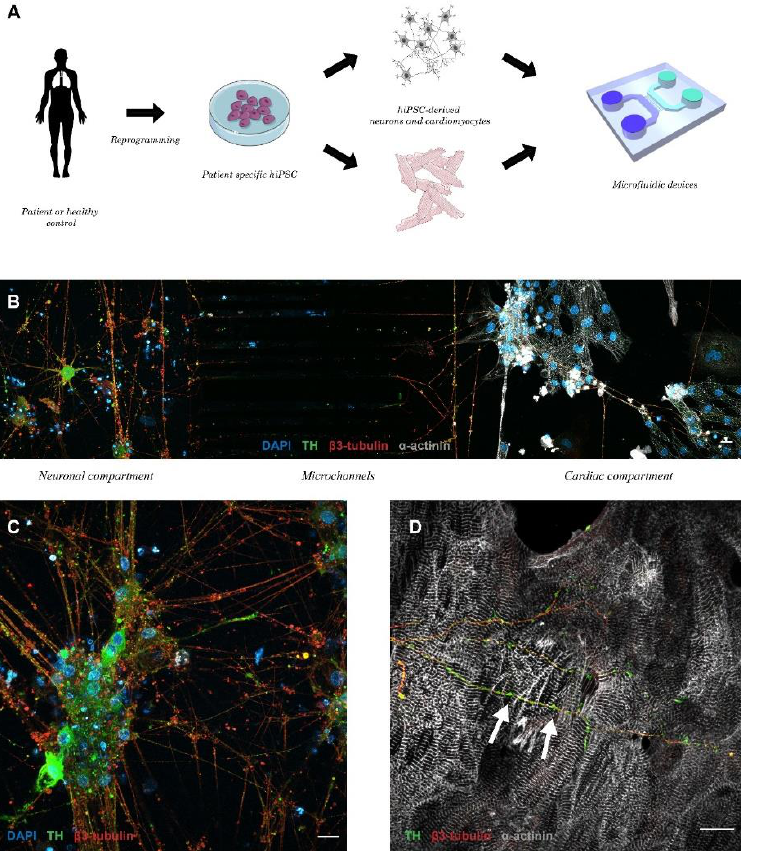
Figure 6. Neuro–cardiac OOC using neurons and cardiomyocytes derived from the same patient- derived hiPSC line. ( A ) Schematic presentation of the production of patient-specific neuro– cardiac OOC using similar control hiPSC line to generate autonomic neurons and cardiomyocytes. ( B ) Global view of neuro–cardiac interaction after 14 days in microfluidic chips of autonomic hiPSC- NRs seeded in neuronal compartment ( C ) projecting to the cardiac compartment. ( D ) Autonomic neurons expressing TH create projection that cross the microchannels and interact with cardiomyocyte (blue: DAPI, r ed: sarcomeric α -actinin, w hite: β3 -tubulin, green: TH, scale bar: 20 µm).